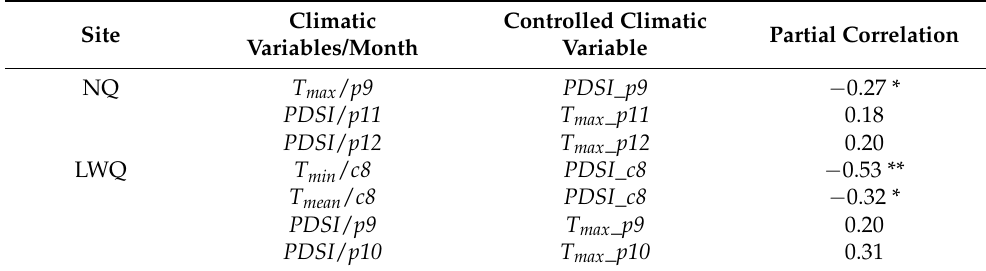
Table 2. Partial correlations between shrub ring-width indices and climatic factors at the two